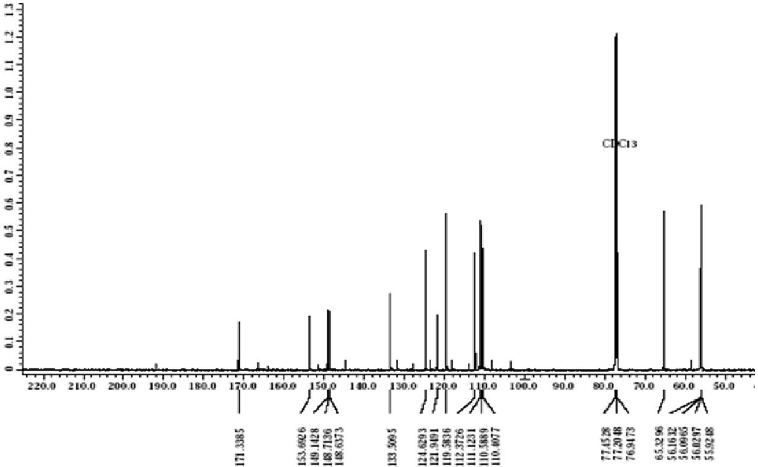
Figure 5. 13 C NMR Spectrum of